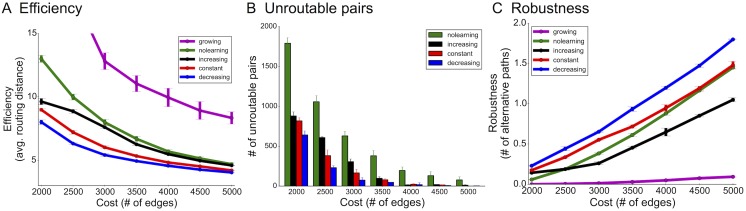
Simulation results for network optimization.(A) Efficiency (lower is better), (B) the number of unroutable pairs (disconnected source-target test pairs), and (C) robustness (higher is better) using the 2-patch distribution. For the growing algorithm, there are no unroutable pairs due to the initial spanning tree construction, which ensures connectivity between every pair to begin with.